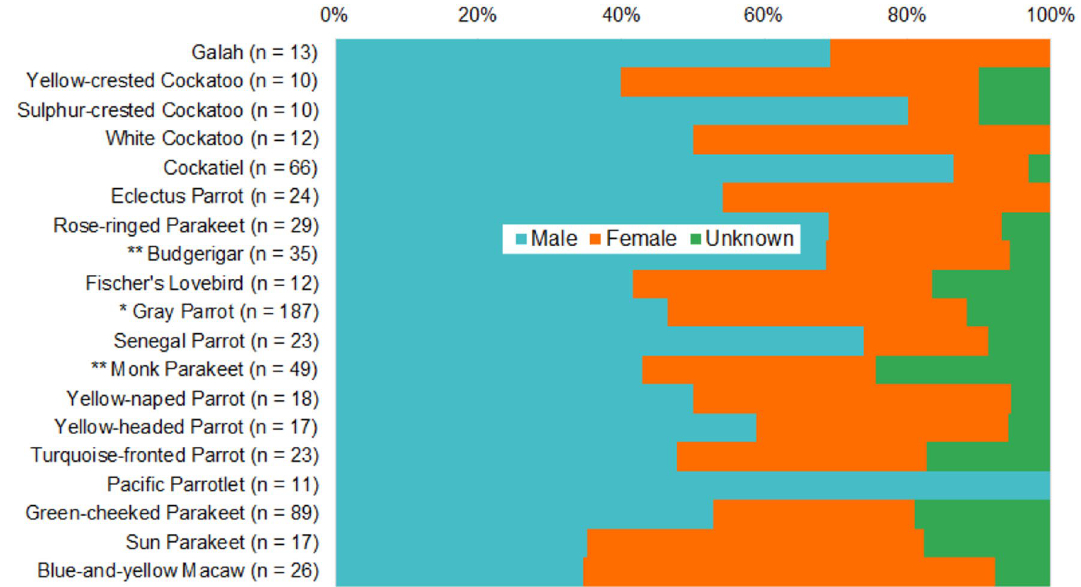
Figure 3. Sampling by sex of the 19 species with ≥ 10 individuals in the data set. Asterisks indicates species in which males are significantly overrepresented among birds sexed with low or medium confidence, relative to the group sexed with high confidence (Chi-squared *p < 0.05, **p < 0.01).